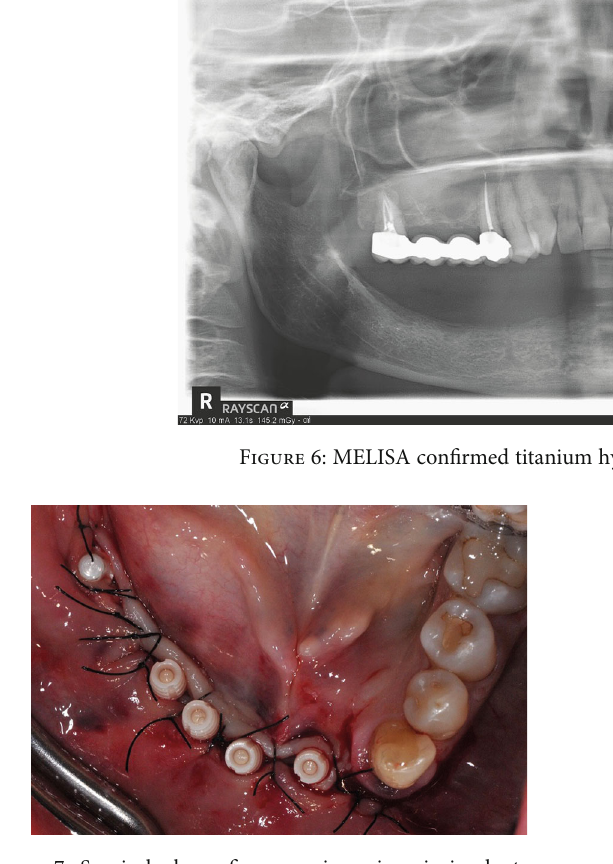
Figure 7: Surgical phase: fi ve one-piece zirconia implants were